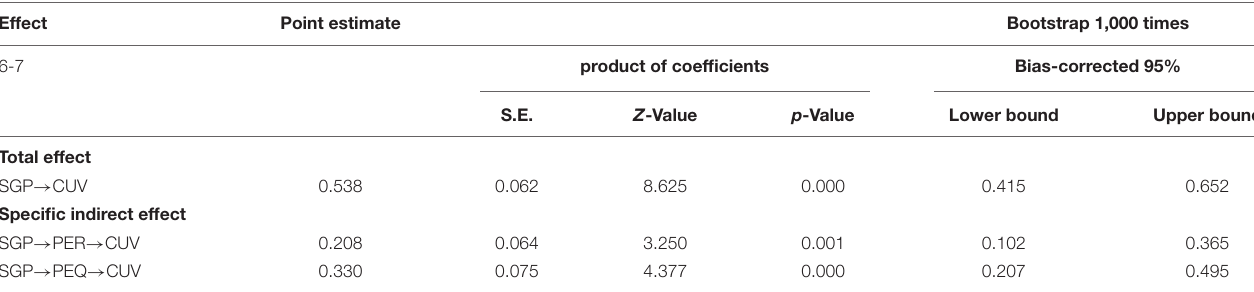
TABLE 7 | The analysis of indirect effects.